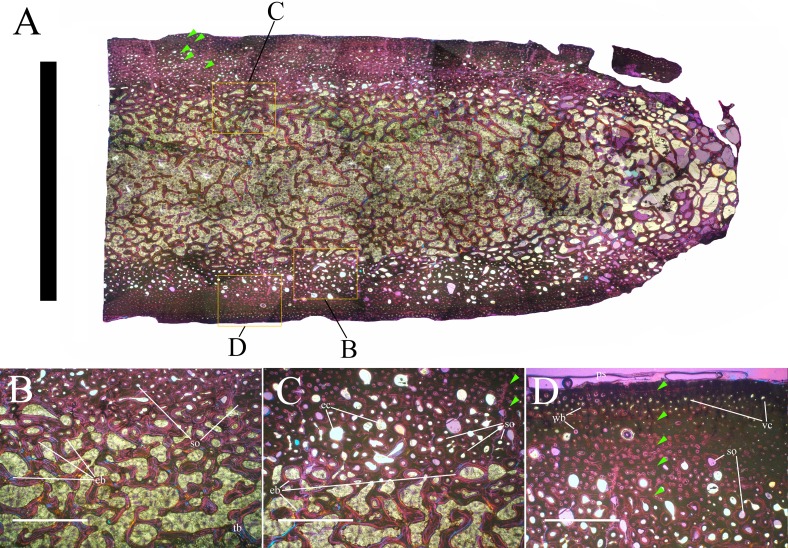
MSNVE 3714, middle neural spine of dorsal vertebra 14, transverse thin section.Panoramic view of the cranial half of the section (A); Haversian systems in the inner most cortex and endosteal bone (B); gradual transition between the compacta and the medullary cortex with erosional cavities and marked remodeling of the primary bone (C); detail of the outer cortex showing absence of an EFS and zonation of the primary bone (D). Abbreviations: eb, endosteal bone; ec, erosional cavities; ps, periosteal surface; so, secondary osteons; tb, trabeculae; vc, vascular canals; wb, woven bone. Green arrows point to the LAGS. Scale bars equal 10 mm in A and 1 mm in B–D.